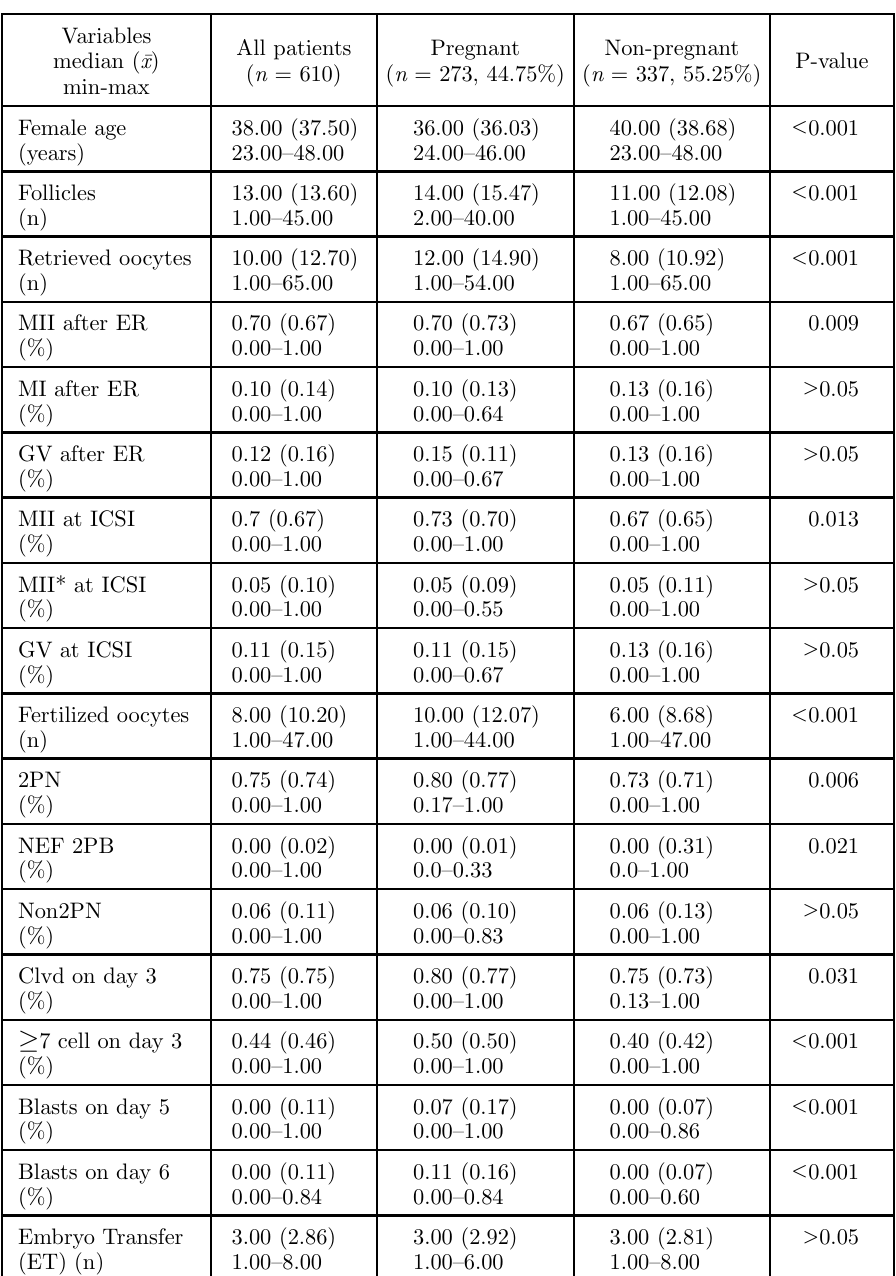
Table 1. Patients’ characteristics (training and validation groups)